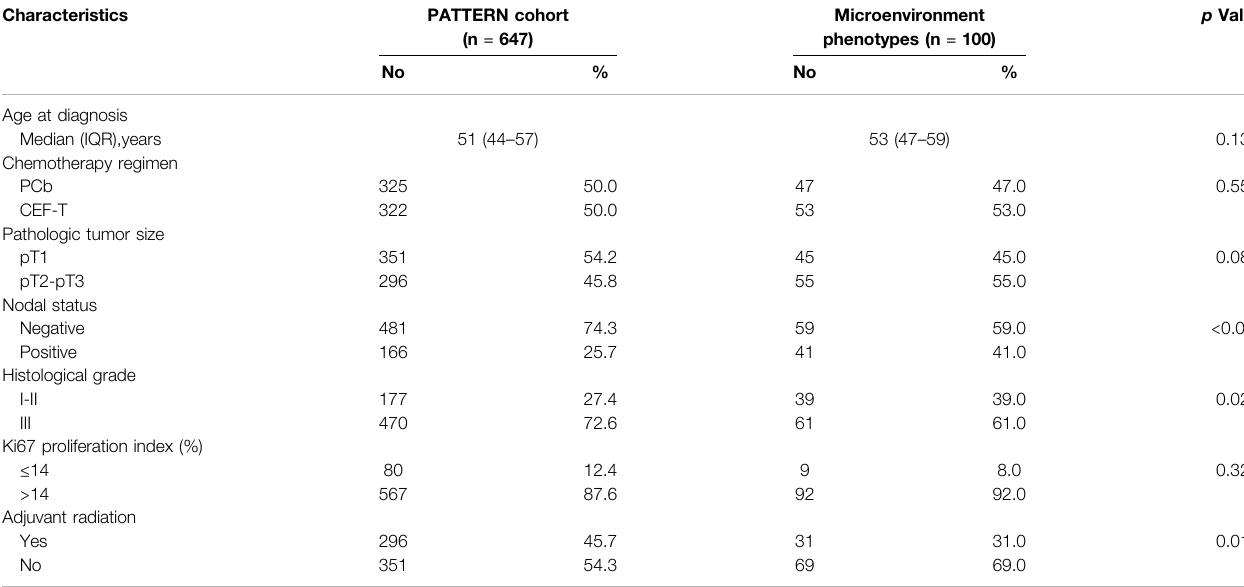
TABLE 2 | Characteristics of the PATTERN cohort and the patients undergoing microenvironment phenotypes clustering.